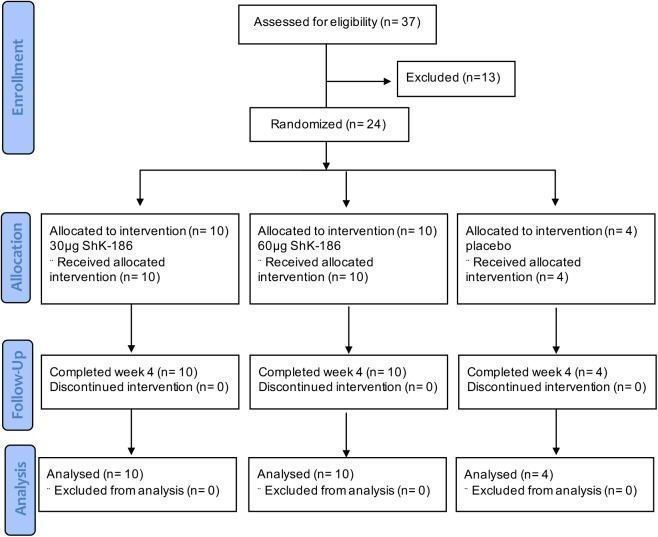
Consort flow diagram.Graphical outline of the design and conduct of the study.